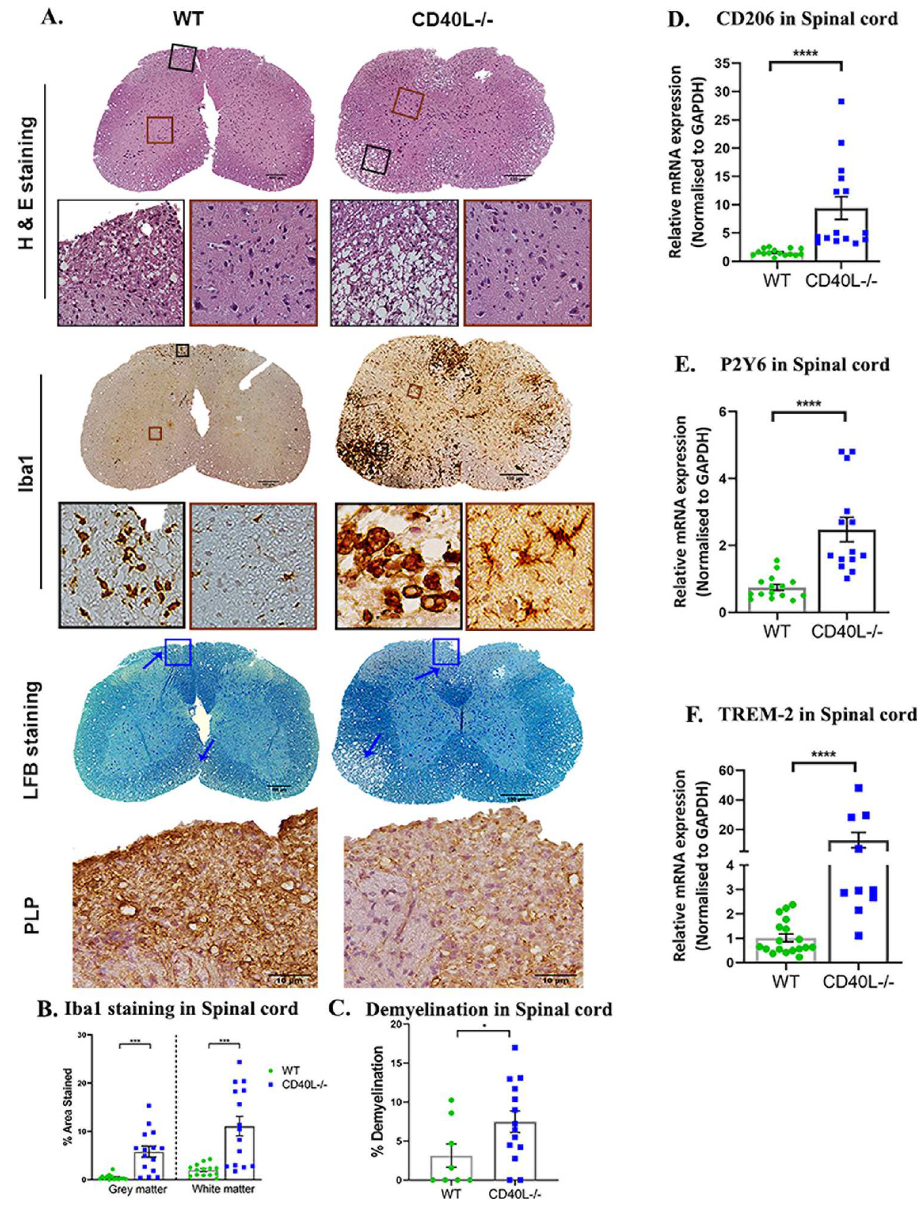
Fig 8. CD40L deficiency exacerbates chronic phase inflammation, demyelination, axon degeneration, and grey matter inflammation in the RSA59 infected spinal cord. (A) On day 30 p.i., cross-sections of RSA59 infected (10000 PFUs) WT and CD40L -/- mouse spinal cords were analyzed for the presence of inflammatory lesions by H&E, microglia/macrophages by Iba1, demyelination by LFB, and myelin protein marker PLP by immunohistochemistry. Black boxed areas represent higher magnification of white matter area, and brown boxed areas represent higher magnification of grey matter below the corresponding spinal cord cross-sections. Blue arrows mark demyelinating plaques on the LFB-stained sections. The blue lined box in the LFB stained sections corresponds to immunohistochemical staining for PLP protein below. Scale bar 100 μ m, 50 μ m, 10 μ m. Quantification of (B) Iba1 staining intensity in the grey and white matter and (C) percent area of demyelination. The relative transcript abundance of (D) CD206, (E) P2Y6, and (F) TREM-2 was analyzed in the infected spinal cords using qRT-PCR and compared between WT and CD40L -/- on day 30 p.i. Results were expressed as mean ± SEM from 3 independent biological experiments (N = 5 for WT and N = 8 for CD40L -/- ). � Asterisk represents statistical significance calculated using unpaired Student’s t-test and Welch correction, p < 0.05 was considered significant. � p < 0.05, ��� p < 0.001, ���� p < 0.0001.